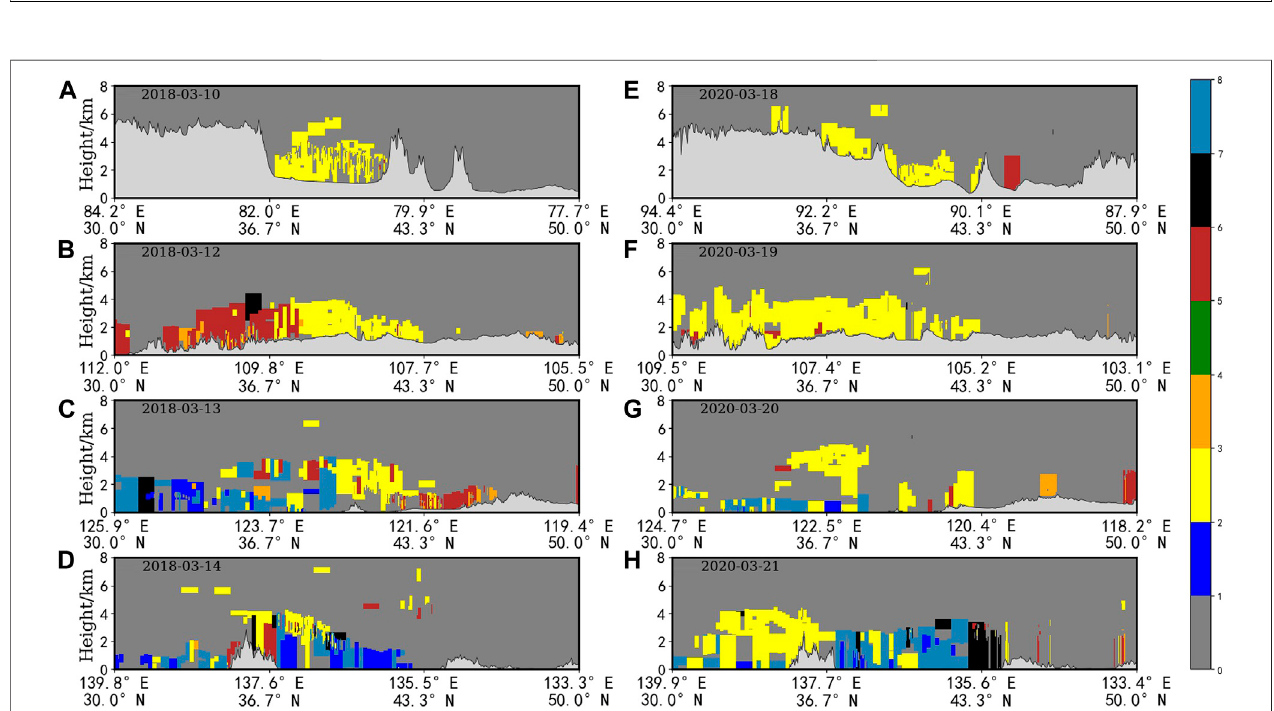
FIGURE4| VerticaldistributionofaerosoltypefromCALIOPonMarch10th,12thto14thin2018 (A – D) ,March18thto21stin2020 (E – H) ,(1 (cid:1) notdetermined,2 (cid:1) clean marine, 3 (cid:1) dust, 4 (cid:1) polluted continental/smoke, 5 (cid:1) clean continental, 6 (cid:1) polluted dust, 7 (cid:1) elevated smoke, 8 (cid:1) dusty marine, black line shows the surface elevation). Changes of aerosol optical characteristics during dust transport process. respectively. During dust transport, the mean values of the PDR and terms of the mean CR value, the decline was 45.93%. In other words, CR decreased by 22.92 and 4.85%, respectively. In terms of PDR, the the change in aerosol optical properties (PDR and CR) in 2020 was decline from r1 ′ to r4 ′ in 2020 was 56.83% of that in 2018. While in about half of that in 2018.